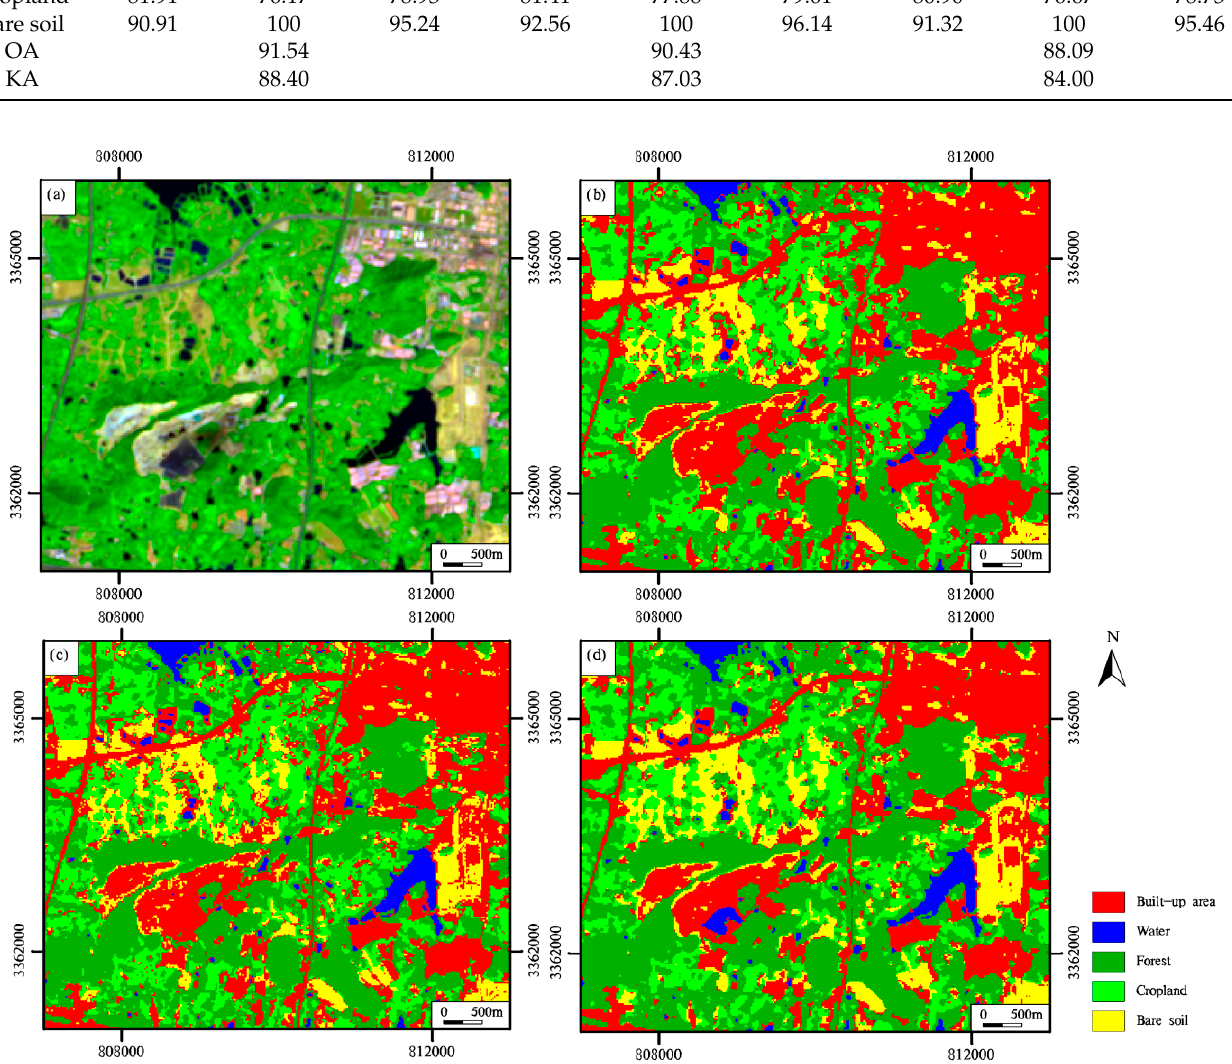
Figure 7. Land cover classification results using Sentinel-2B MSI image alone with the SVM-CK algorithm ( a ), the SVM algorithm ( b ), and the KELM-CK algorithm ( c ).